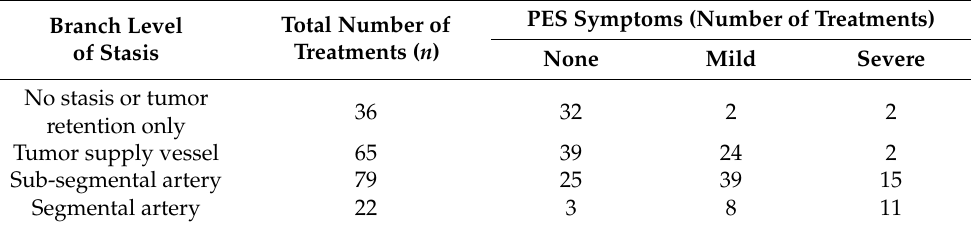
Table 3. Branch level of temporary stasis associated with incidence and severity of postembolization syndrome (PES).